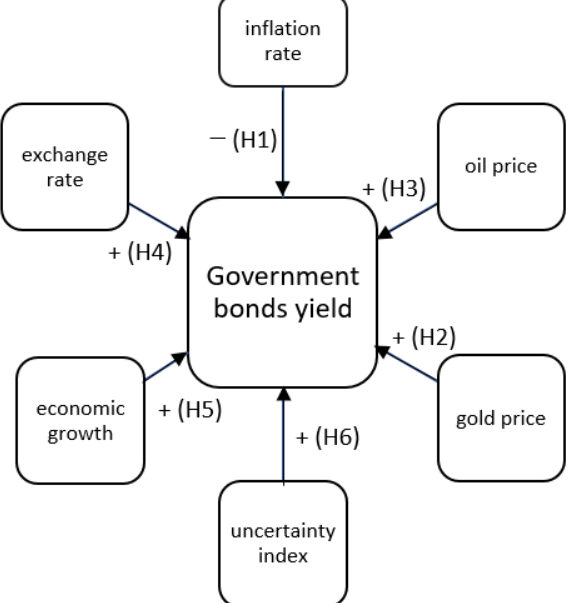
Figure 1. The conceptual model of research.